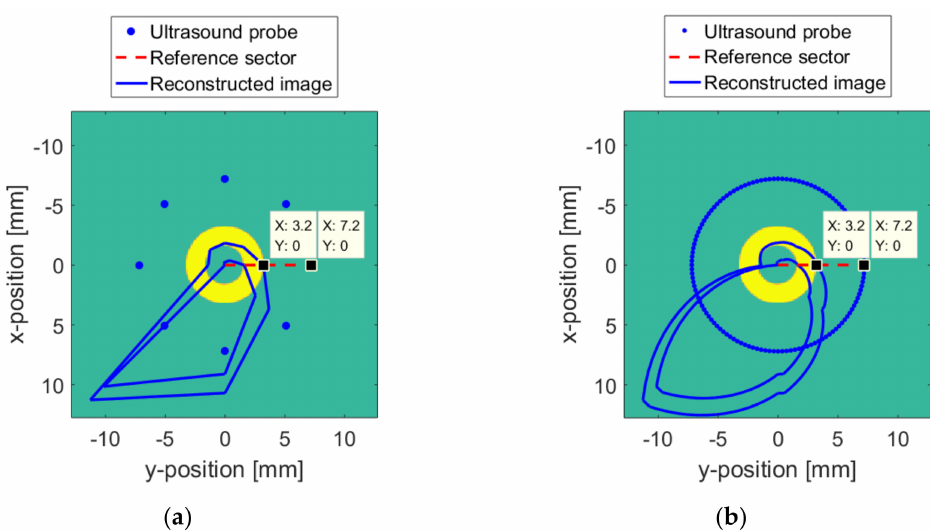
Figure 19. Reconstructed image when the TMC changes without the PSM: ( a ) ∆ v = 8; ( b ) ∆ v =